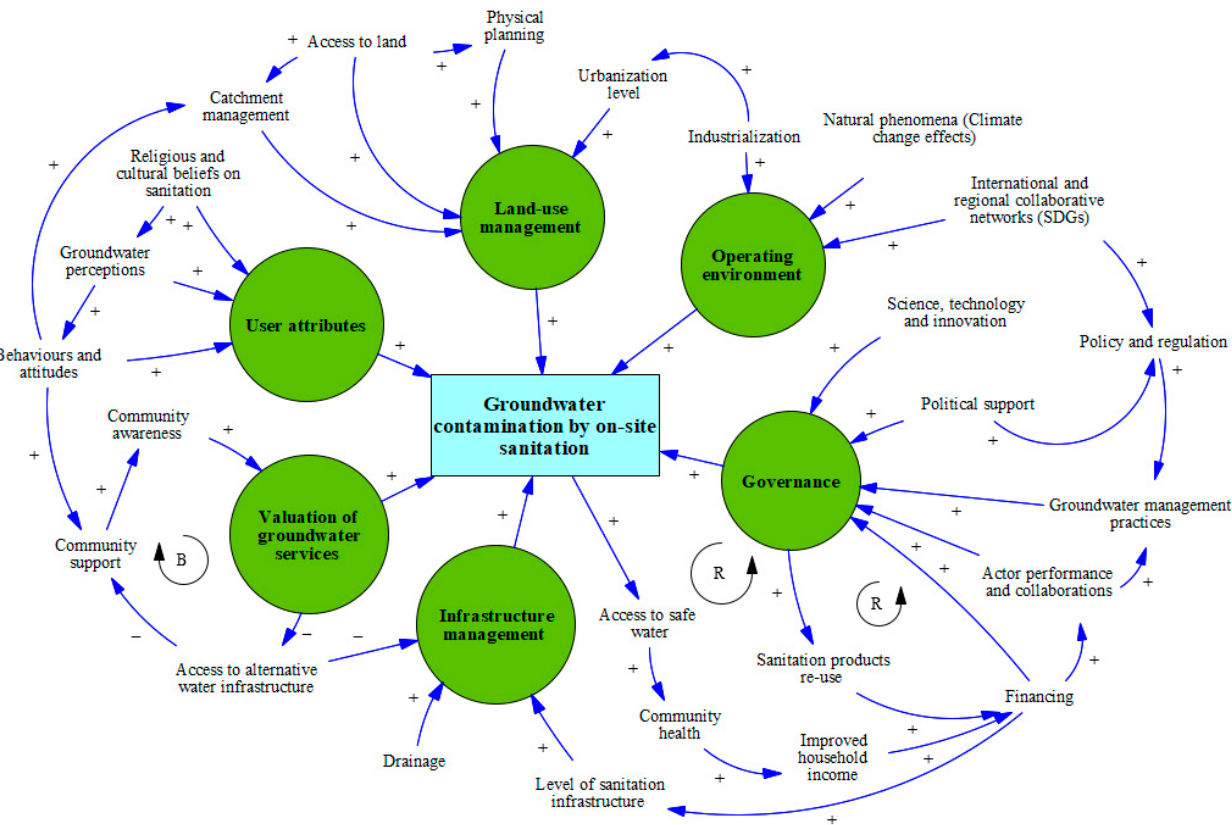
Figure 4. A causal loop diagram representing socio-institutional drivers of groundwater contamination by on-site sanitation in the Bwaise informal settlement, Kampala.